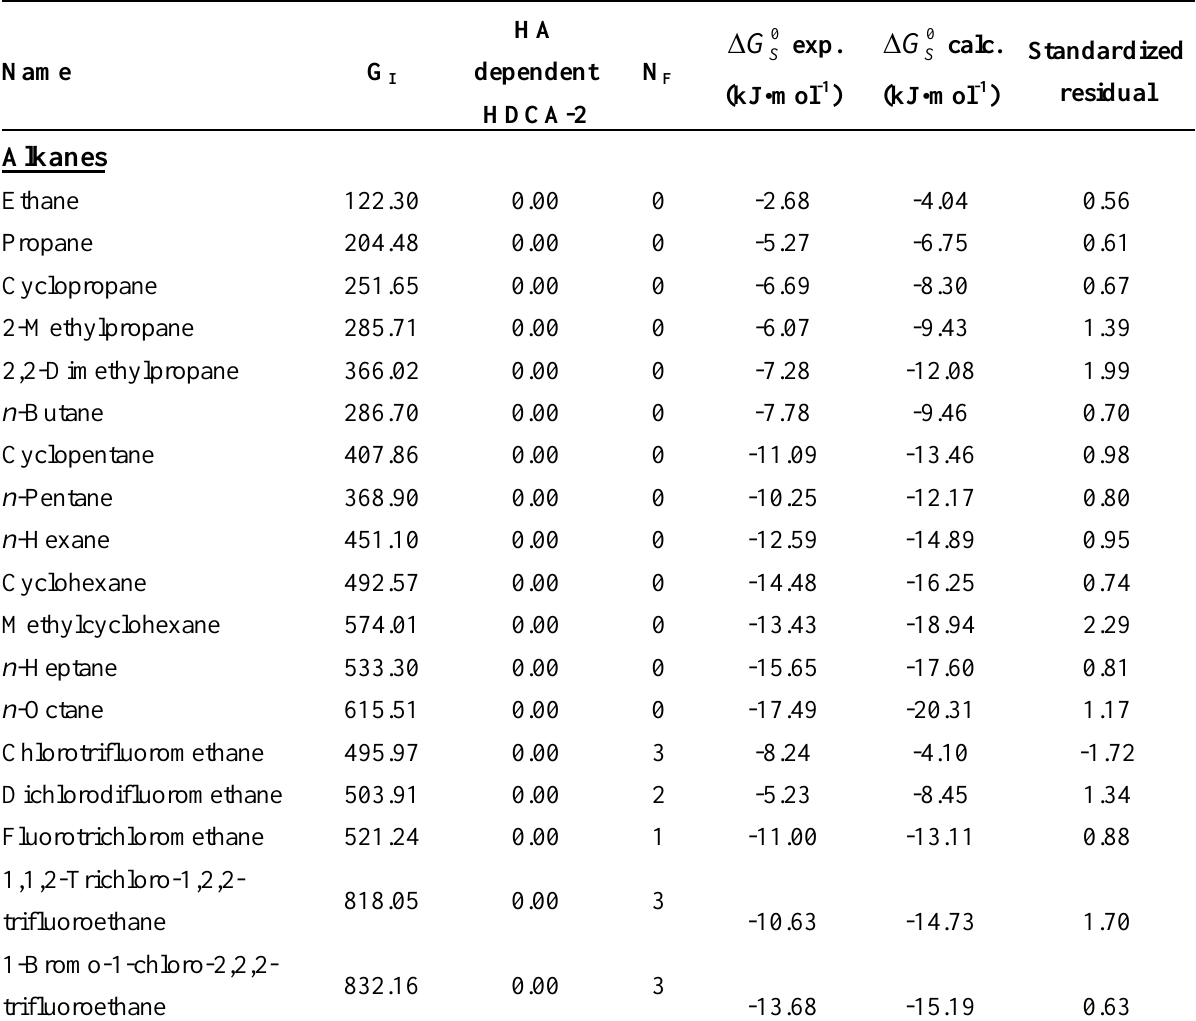
Table 3 . Molecular descriptors and values of experimental and calculated 0 training